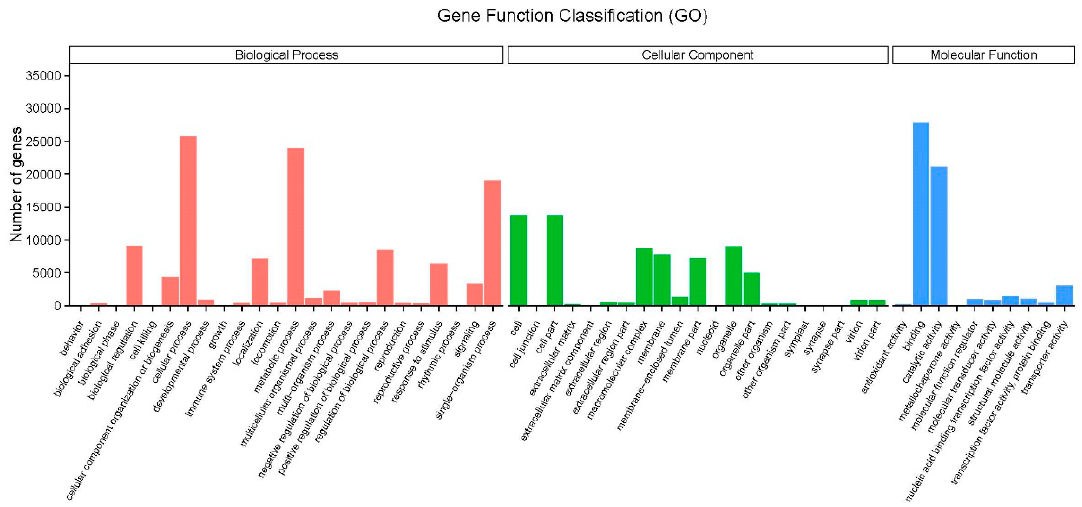
Figure 2. Histogram of gene ontology (GO) classification. The results are summarized in three main categories: biological process, cellular component, and molecular function.